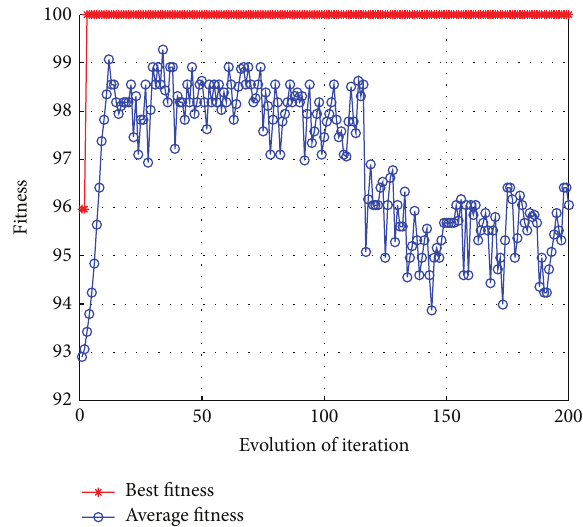
Figure 6: The classification result of the hybrid SPSO and SVM